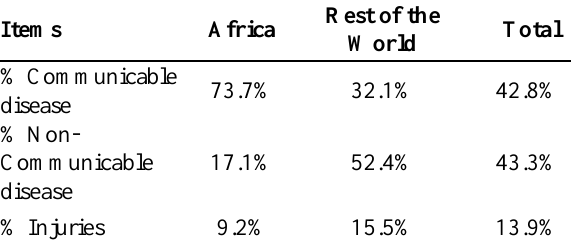
Table 3 : Estimated Burden of Disease in Africa Relative